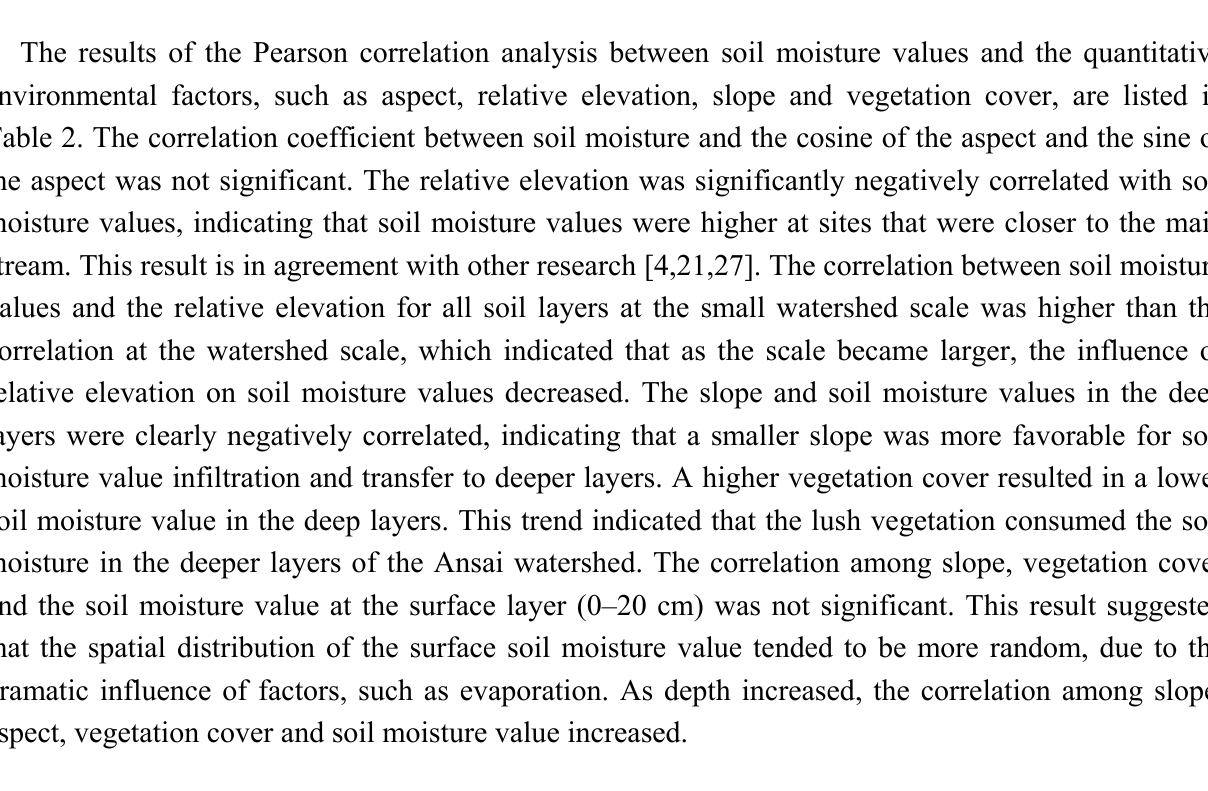
Table 2. Pearson correlation coefficients between quantitative environmental factors and cross-sectional soil moisture